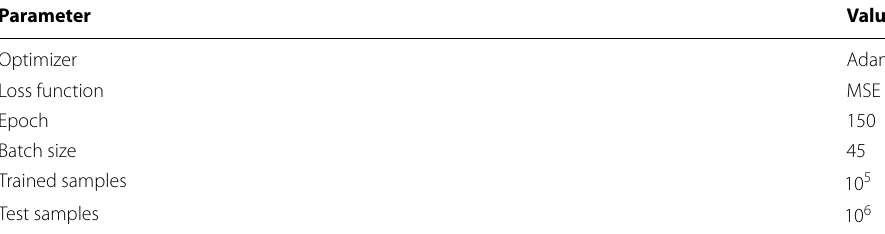
Table 2 Parameters for the autoencoder